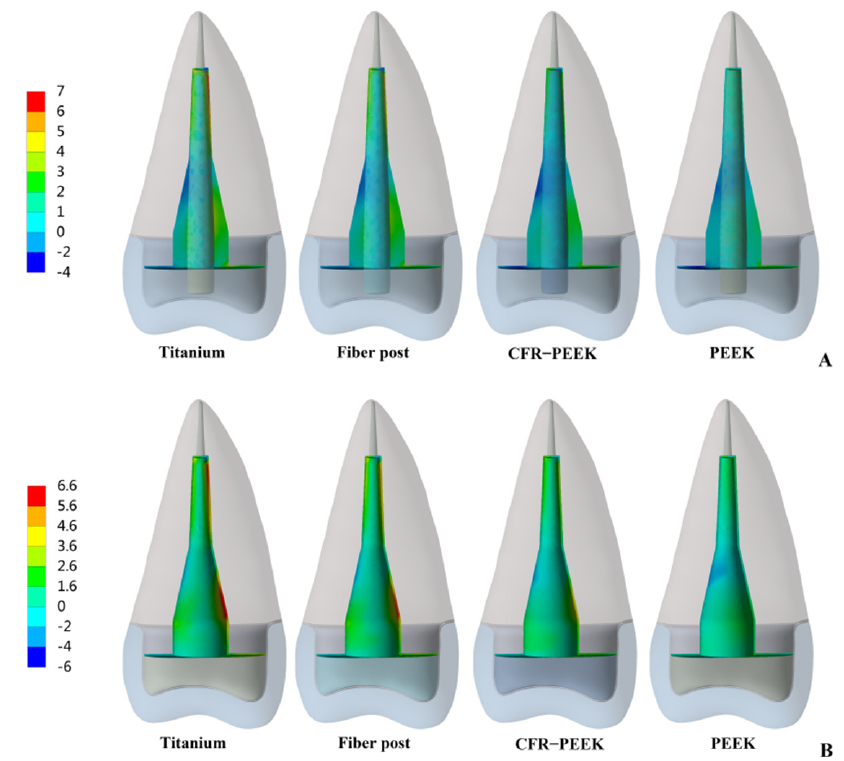
Figure 9. Distributions of MPS at root cement. ( A ) Prototype 2. ( B ) Prototype 3.